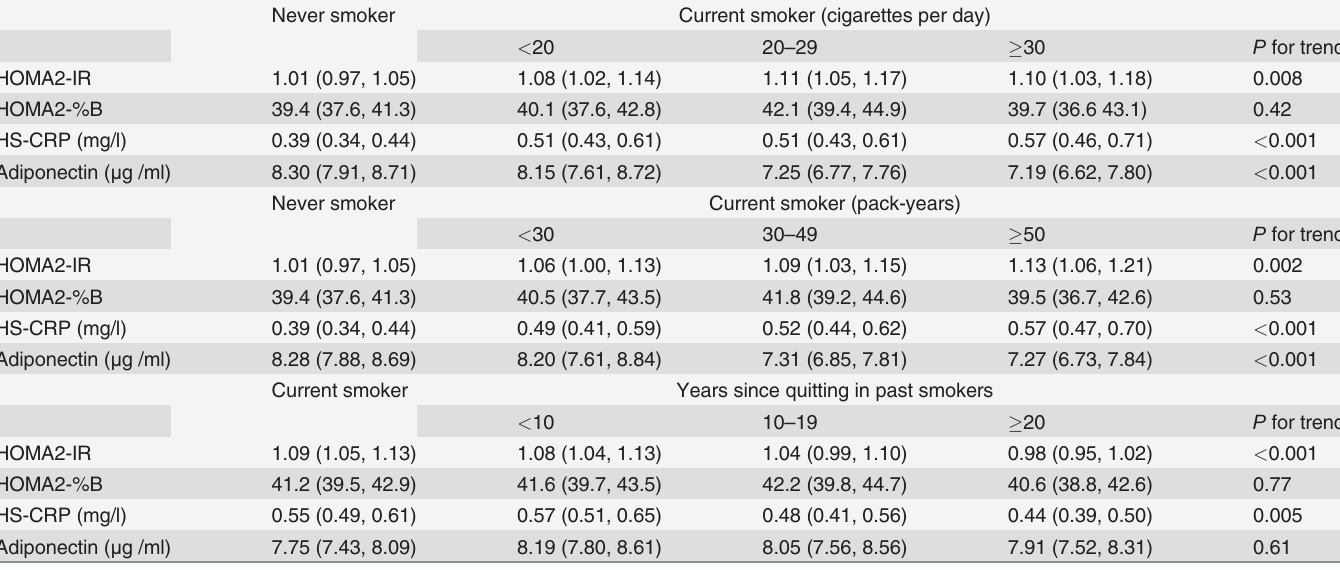
Table 5. Age-adjusted mean values of HOMA2-IR, HOMA2-%B, HS-CRP, and adiponectin according to the amount of smoking and years since quitting.